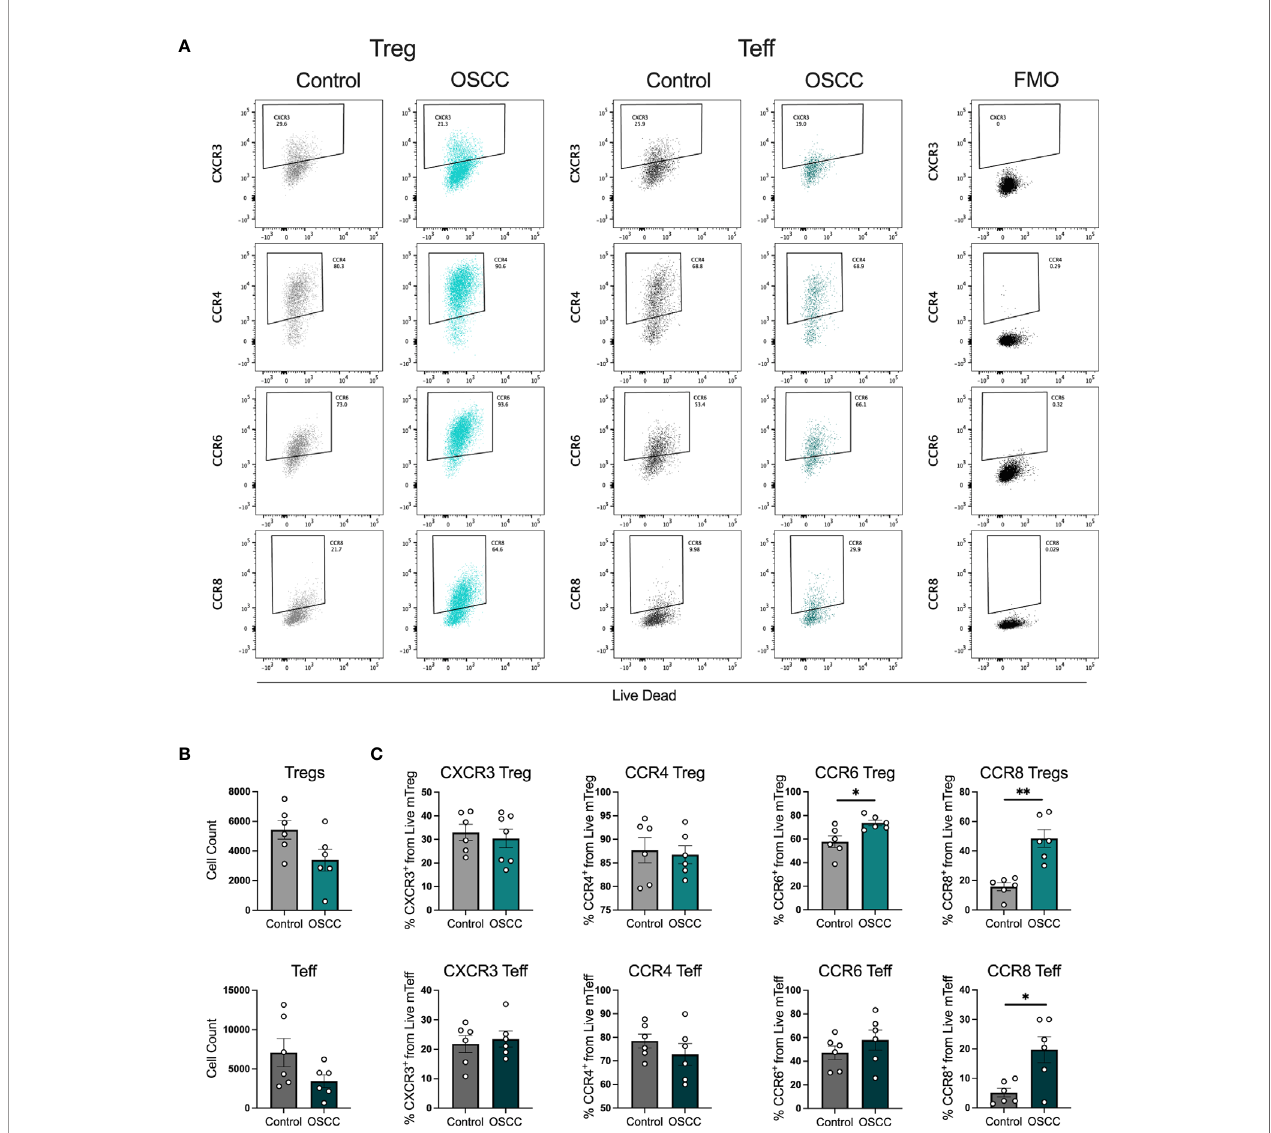
FIGURE 2 | OSCC secretome up regulates CCR8 expression in Treg and Teff. (A) Representative dot plots of chemokine receptor expression CXCR3, CCR4, CCR6 and CCR8 in Tregs and Teff after co-culture with control or OSCC secretome. Brie fl y, sorted memory Tregs and Teff obtained from peripheral blood from 3 healthy donors were pre-activated with anti-CD3/CD28 beads (1:5) in the presence of IL-2 (1000U). After activation, 2x10 5 Tregs and Teff were co-cultured with secretomes from OSCC or control samples for 48h. After co-culture, cells were stained with Live/Dead dye, chemokine receptor expression and counted with counting beads. (B) Comparison of cell counts between Tregs and Teff co-cultured with OSCC or control secretome. (C) Comparison of CXCR3, CCR4, CCR6 and CCR8 expression between Tregs and Teff co-cultured with OSCC or control secretome. Data are presented as mean ± SEM using bars with scatter dot plots (Unpaired t test). For all statistical tests, ∗∗ p < 0.01 and ∗ p < 0.05 were considered signi fi